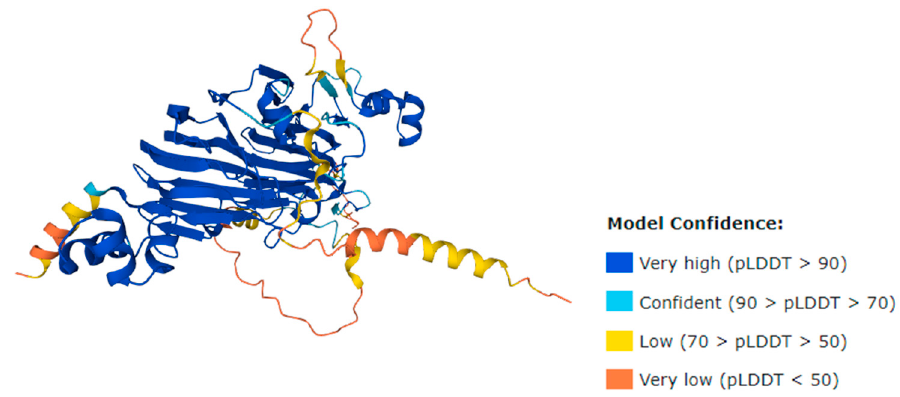
Figure 8. Glutelin in the rice bran product developed based on structure modelling. Prolamin is the smallest fraction among the four main protein fractions in rice bran.